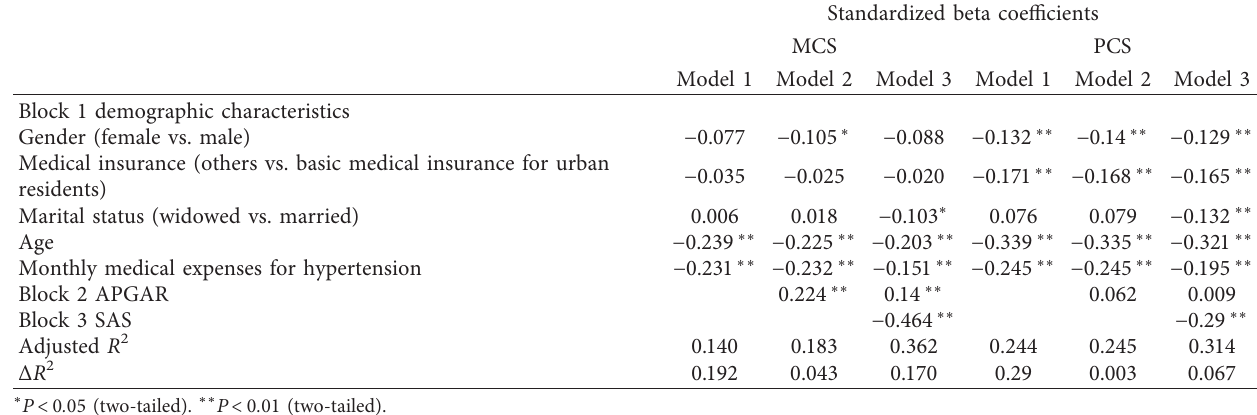
Table 3: Hierarchical multiple regression predicting MCS and PCS.